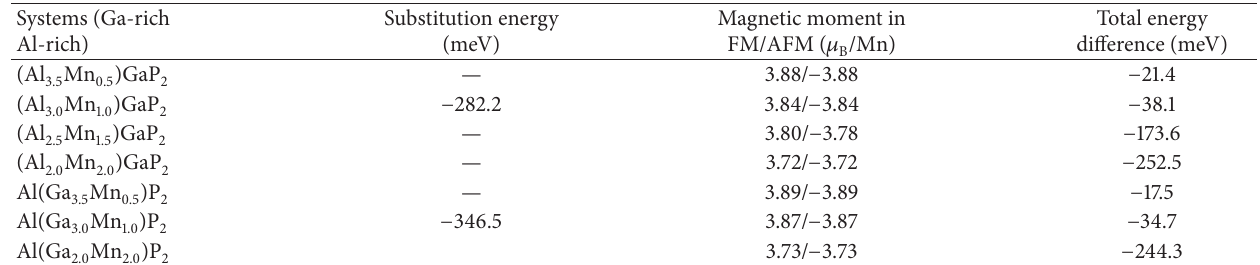
, Mn , Mn , and Mn correspond to the concentration of 3.125, 6.25, 9.375, and 12.5% Mn, respectively. 0.5 1.0 1.5 2.0